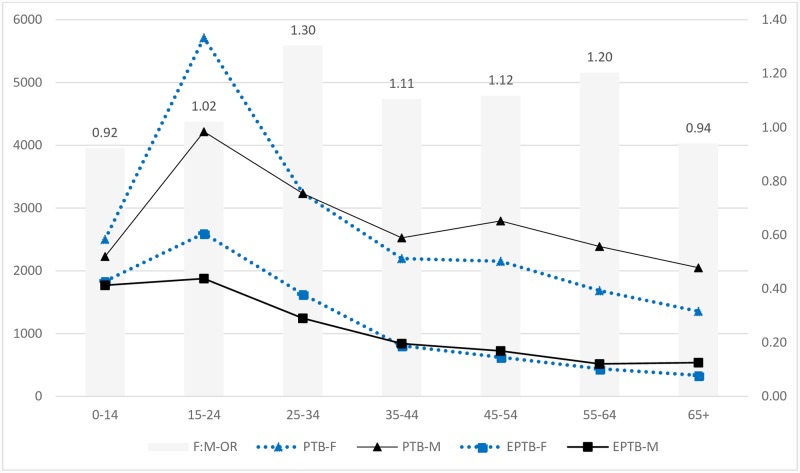
Age and sex-specific pulmonary and extrapulmonary tuberculosis case notifications and age-specific odds of female for having extrapulmonary tuberculosis.PTB-M; Male pulmonary tuberculosis patients, PTB-M- Female pulmonary tuberculosis patients, EPTB-F, Female extrapulmonary tuberculosis patients, EPTB-M, Male extrapulmonary tuberculosis patients, F: M-OR: Female to male odds ratio for EPTB. TB cases notified are shown on the primary axis and OR on the secondary axis.